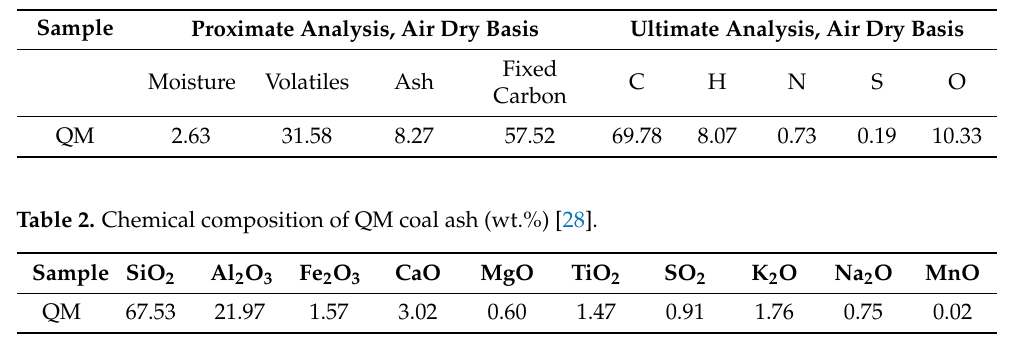
Table 1. Property analysis of QM coal (wt.%) [28].